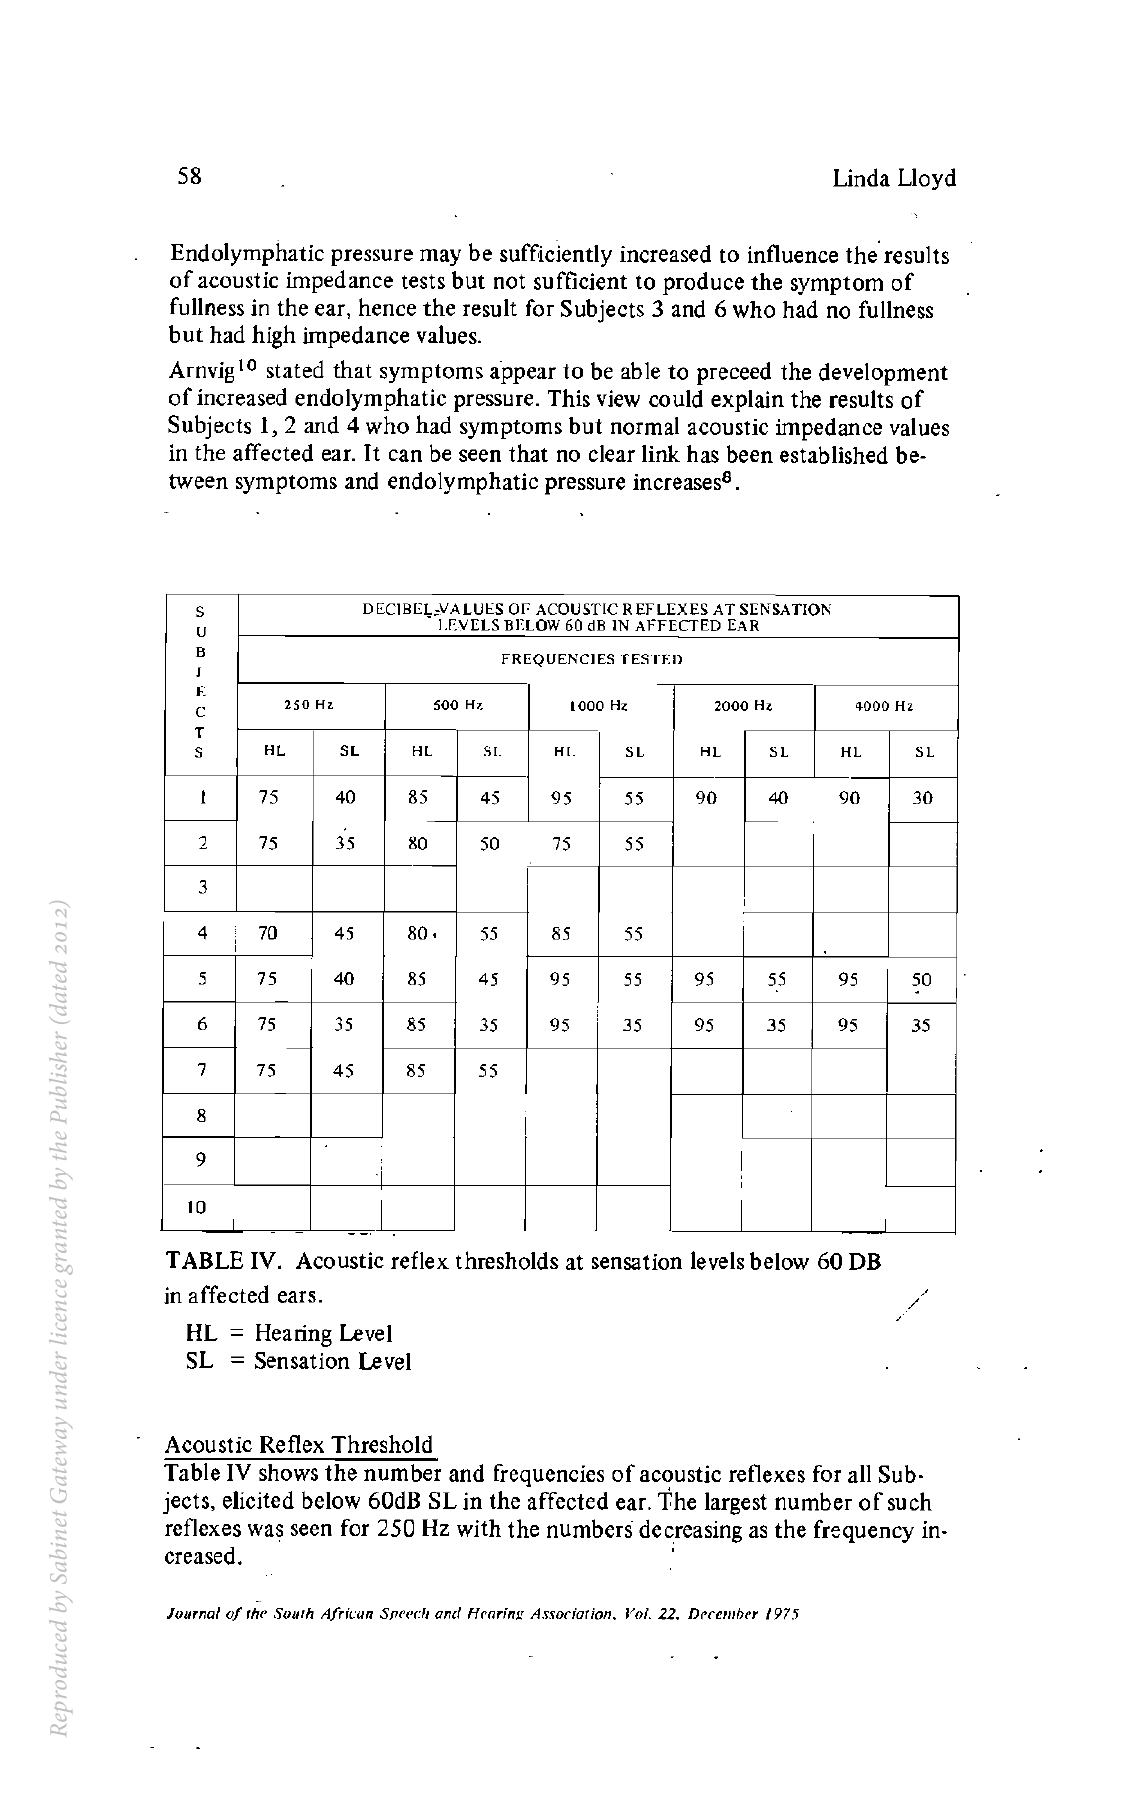
TABLE IV. Acoustic reflex thresholds at sensation levels below 60 DB in affected